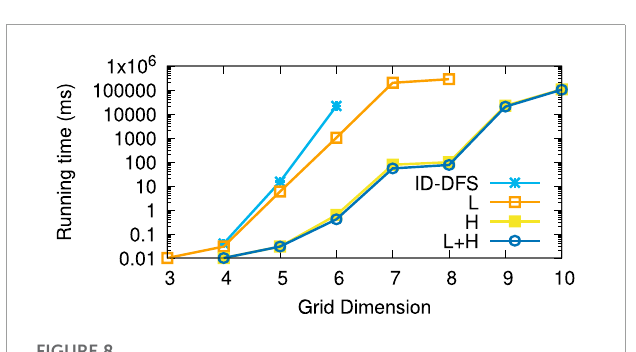
FIGURE 8 Average running times (in ms) for the type (c) (random walk) grids.